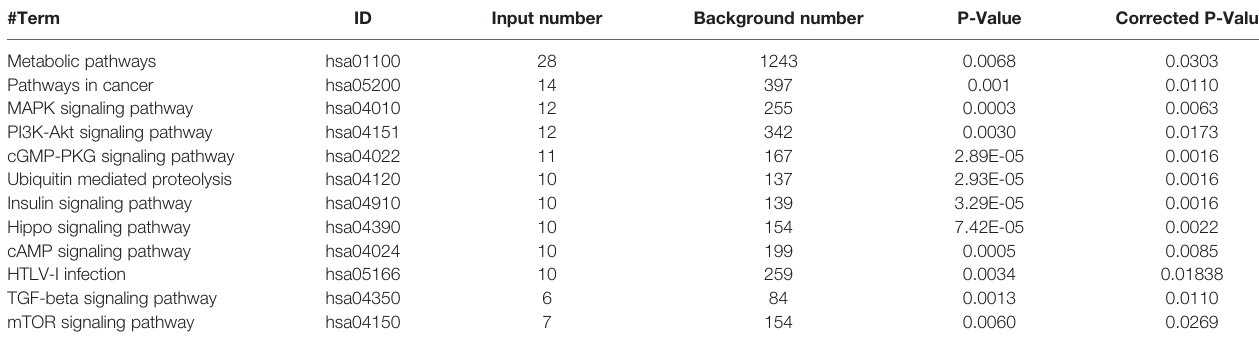
TABLE 3 | The Kyoto Encyclopedia of Genes and Genomes (KEGG) pathway enrichment analysis of miR-21-3p downstream targets (top 12 listed here).